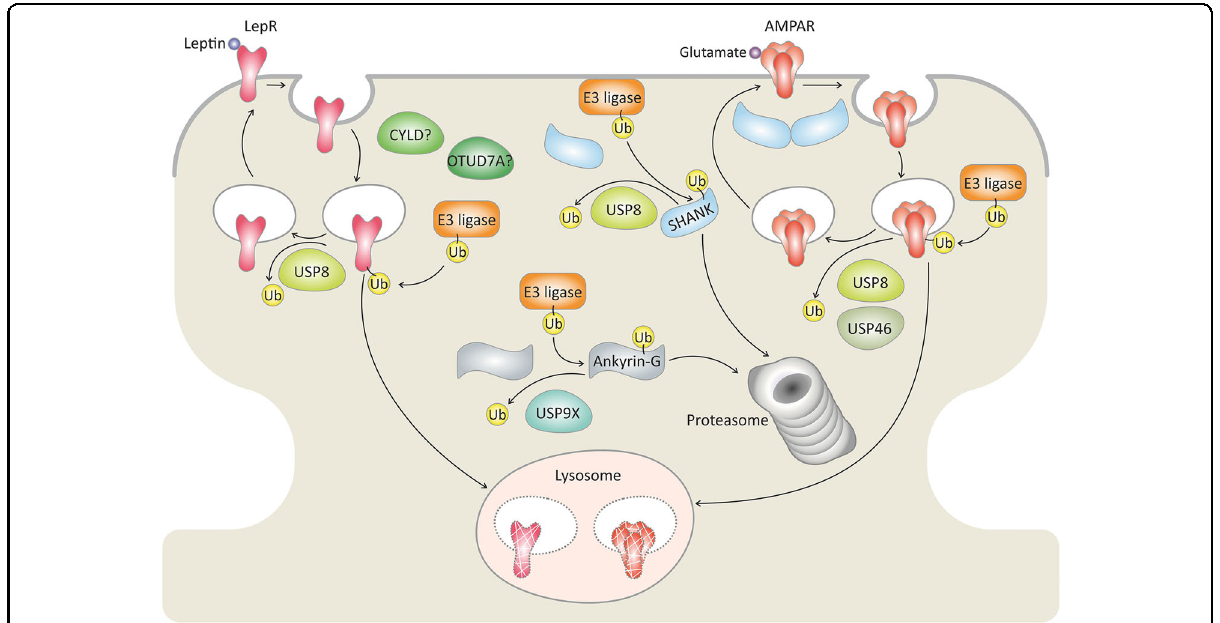
Fig. 2 An emerging model for DUB regulation of synaptic plasticity. Activation of postsynaptic glutamate receptors controls neuron excitability. The postsynaptic density is enriched with a growing number of DUBs that antagonize E3-ligases and remove ubiquitin (Ub) chains, thereby protecting designated substrates from degradation by the lysosomes or the proteasome. Certain DUBs regulate the degradation and surface localization of the glutamate receptor, AMPAR. Moreover, a number of DUBs support the formation and function of the glutamatergic synapse by regulating the levels of scaffold proteins (SHANK and Ankyrin) and the leptin receptor (LepR). DUBs with yet unknown substrates are labeled with a question mark (?). The Ub symbol in this image indicates a polyubiquitin